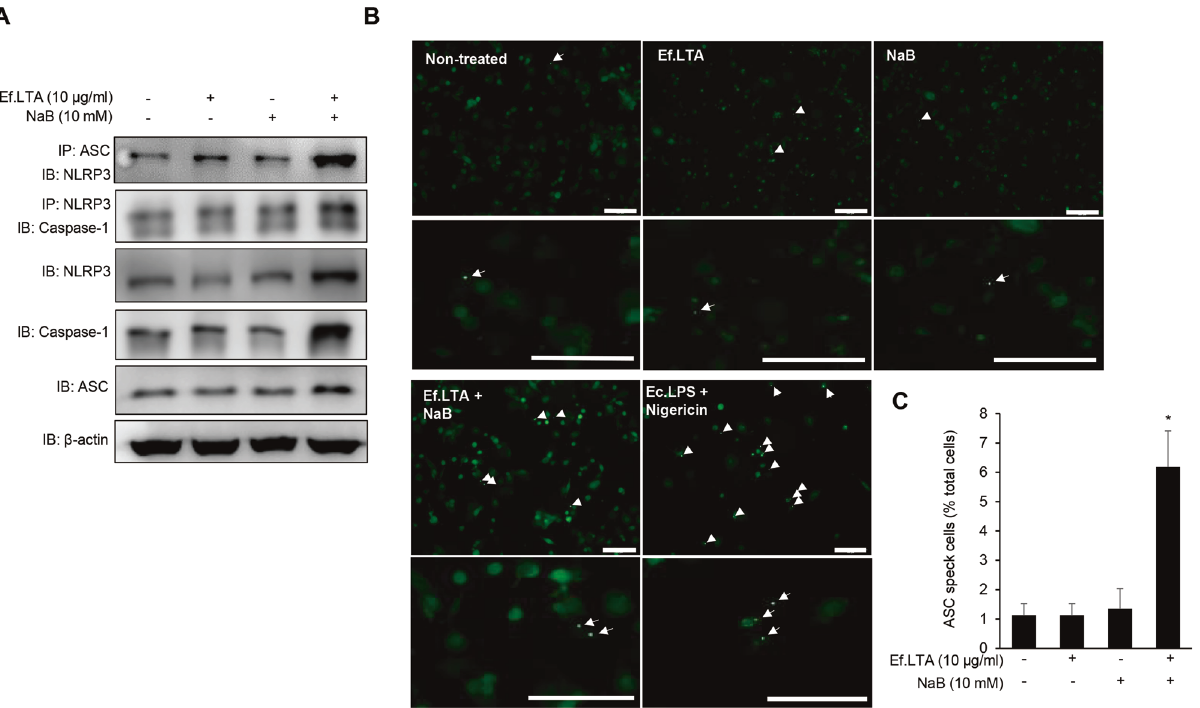
Fig. 4 Ef.LTA/NaB activates the NLRP3 in fl ammasome. A PMA-differentiated THP-1 cells were treated with NaB (10 mM) in the presence or absence of Ef.LTA (10 μ g/ml) for 6 h. The cells were lysed, and ASC or NLRP3 proteins were immunoprecipitated with appropriate antibodies. Then, the immunoprecipitated complexes were analyzed by Western blotting using speci fi c antibodies to NLRP3 or caspase-1. The expression of NLRP3, caspase-1, and ASC was determined by Western blotting. B , C PMA-differentiated ASC-GFP-THP-1 cells were treated with Ef.LTA (10 μ g/ml), NaB (10 μ M), or Ef.LTA/NaB for 6 h. B The cells were fi xed, observed and photographed by fl uorescence microscopy. The arrows indicate ASC speck formations. C ASC specks per cell were enumerated using ImageJ software. E. coli LPS (1 μ g/ml)/Nigericin (10 mM) was used as a positive control. * p <